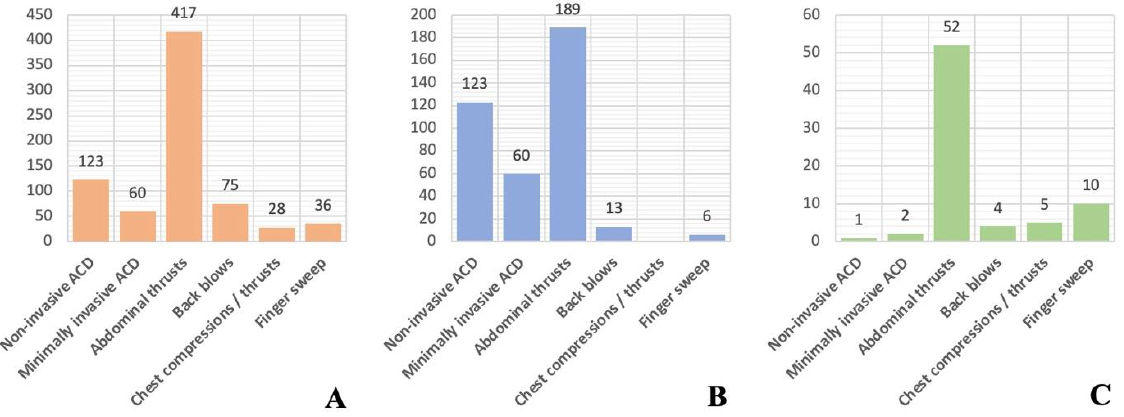
Figure 2. Reported counts in academic literature of effectiveness and safety outcomes for airway clearance devices and traditional FBAO interventions: ( A ) Relief of FBAO ( B ) Survival* ( C ) Adverse events [8,9]. * Chest compressions/thrusts had survival with good neurological outcome reported, not survival